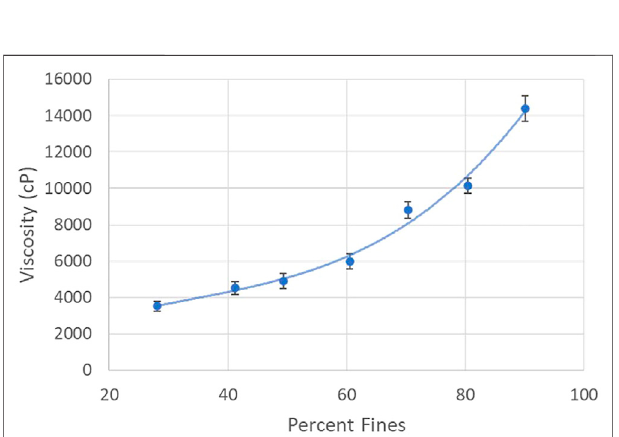
FIGURE 4 | Correlation of percent fi nes with energy consumption. Average of three processing runs with standard deviations for both percent fi nes and energy consumption displayed.